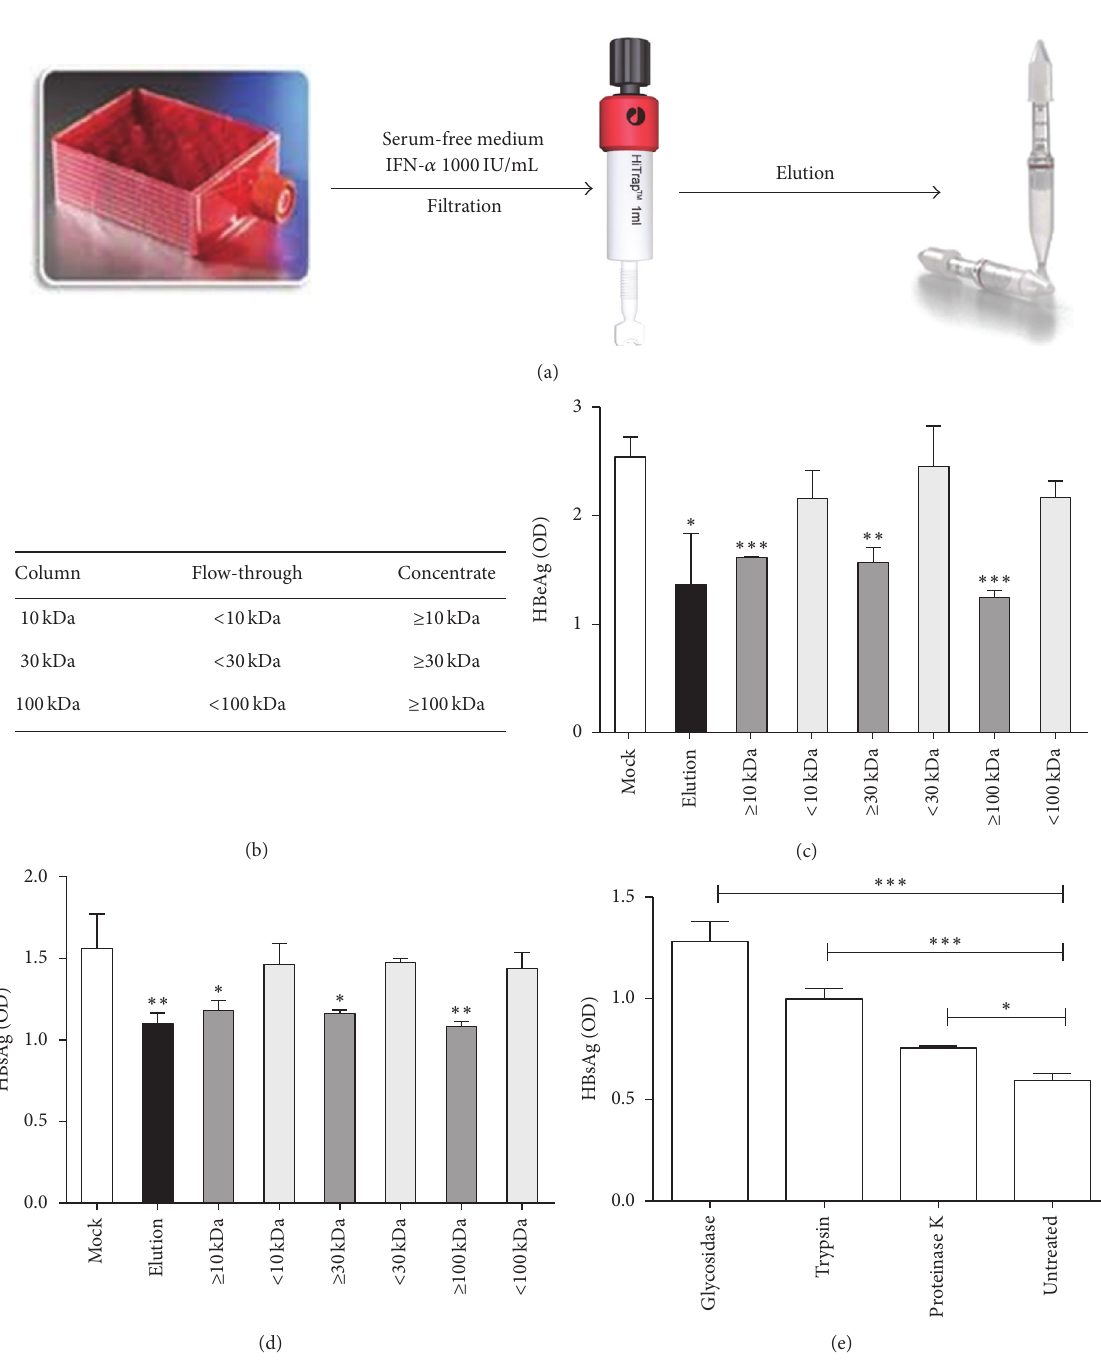
Figure 6: Size exclusion of IFN- 𝛼 induced binding inhibitors. (a) HepaRG cells were cultivated in hyperflask. After differentiation, cells were stimulatedwith1000 IU/mLIFN- 𝛼 foronedayandthenfedfreshserum-freemedium.Theheparinbindingfractionwaspurifiedfromheparin columns and protein concentration columns with different cutoffs were used to further separate the fractions by protein size. (b) Protein size of each fraction. (c) Differentiated HepaRG cells were incubated with indicated samples for 24 hours and then infected with HBV. HBeAg was evaluated by ELISA 4 days after infection. (d) Highly purified HBV SVPs from chronic HBV carriers were added to heparin-coated (25 𝜇 g/mL) 96-well plate and treated with different fractions. Plates were incubated for 2 h at 37 ∘ C, and heparin-bound SVPs were detected using an HBsAg ELISA kit. (e) Differentiated HepaRG cells were incubated with elution treated by glycosidase, or trypsin, or proteinase K for 24 hours and then infected with HBV. HBsAg was evaluated by ELISA 4 days after